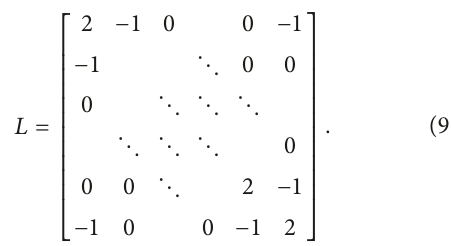
network topology as Figure 1. The Laplacian matrix is